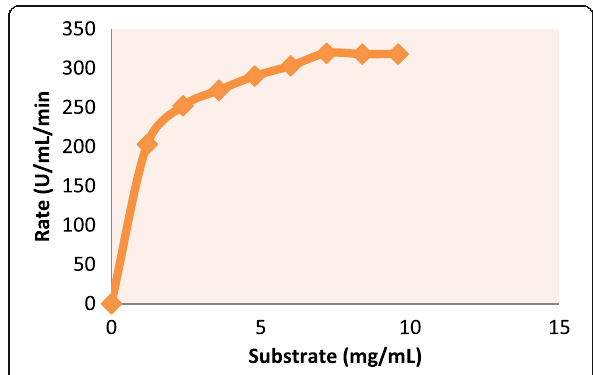
Fig. 8 Michaelis-Menten plot of purified serratiopeptidase